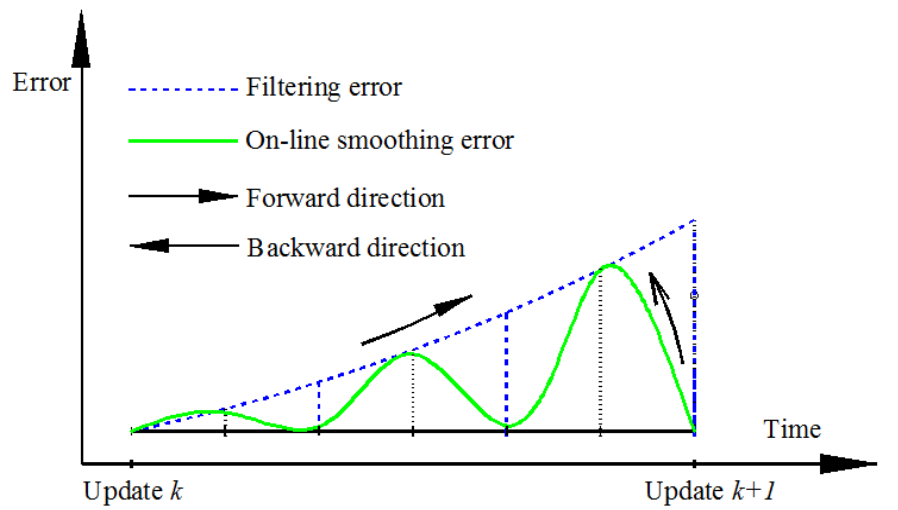
Figure 6. Behavior of on-line smoothing error with discontinuous